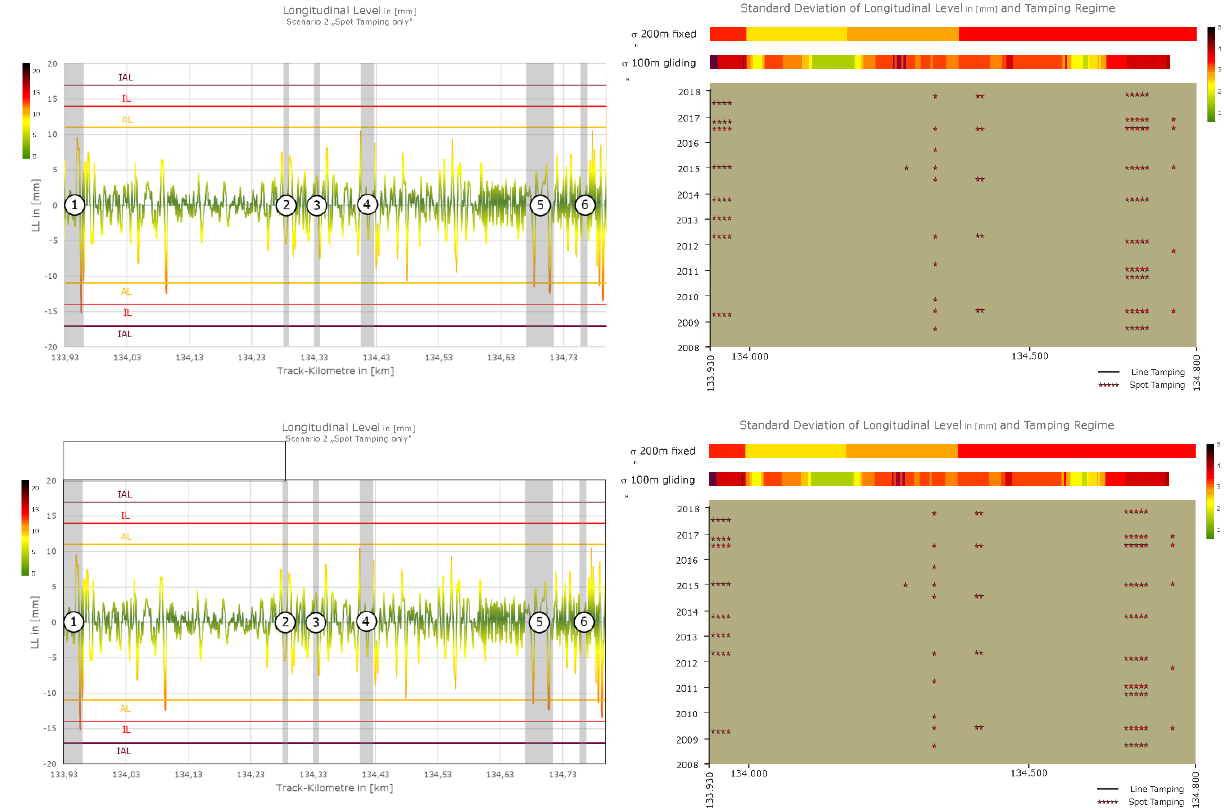
Figure 5. Showing the forecasted Longitudinal Level in Q12018 ( left ) including the Single Failures (1 to 6), SDLL for 100 m gliding and 200 m fixed Base at Q12018 and the executed Spot Tamping tasks over Time ( right ) for the predicted Scenario 2 (“Spot Tamping only”).